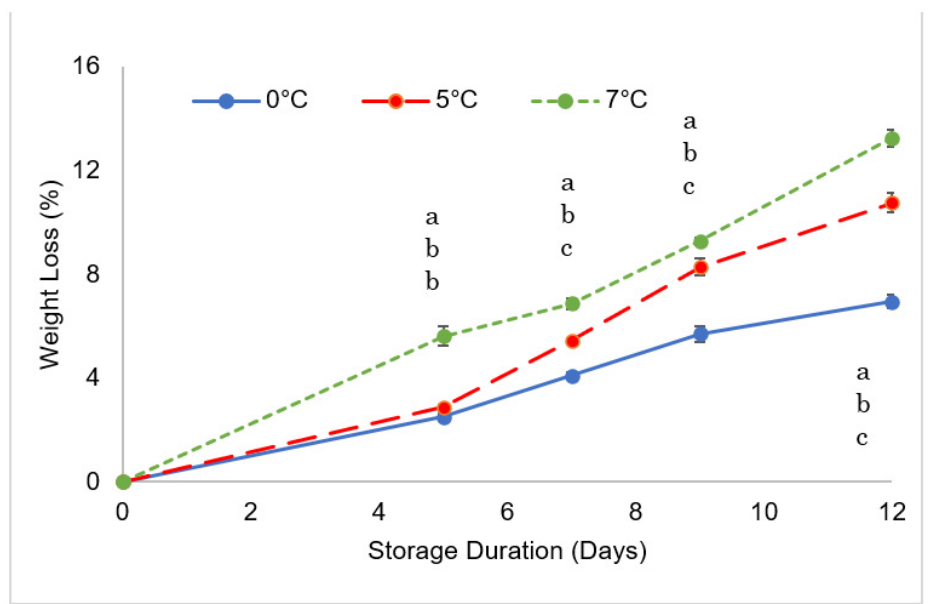
Figure 3. Weight loss changes in goji berries during storage at 0, 5, and 7 ◦ C. Values marked with the same letter on the same sampling day are not significantly different, according to a Tukey’s test ( p <